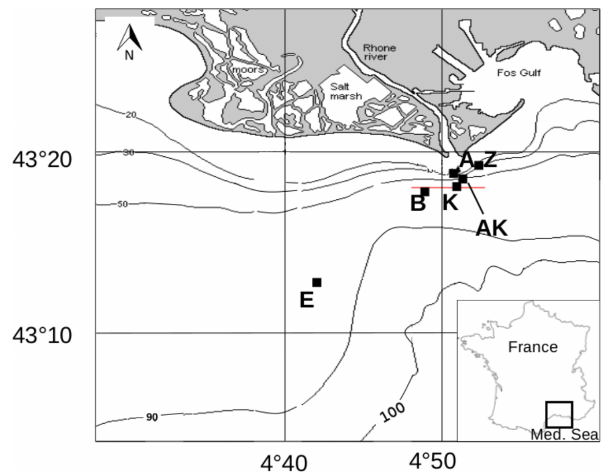
Figure 1. Map of the Rhône River prodelta with the stations inves- tigated during the AMOR-B-Flux cruise in September